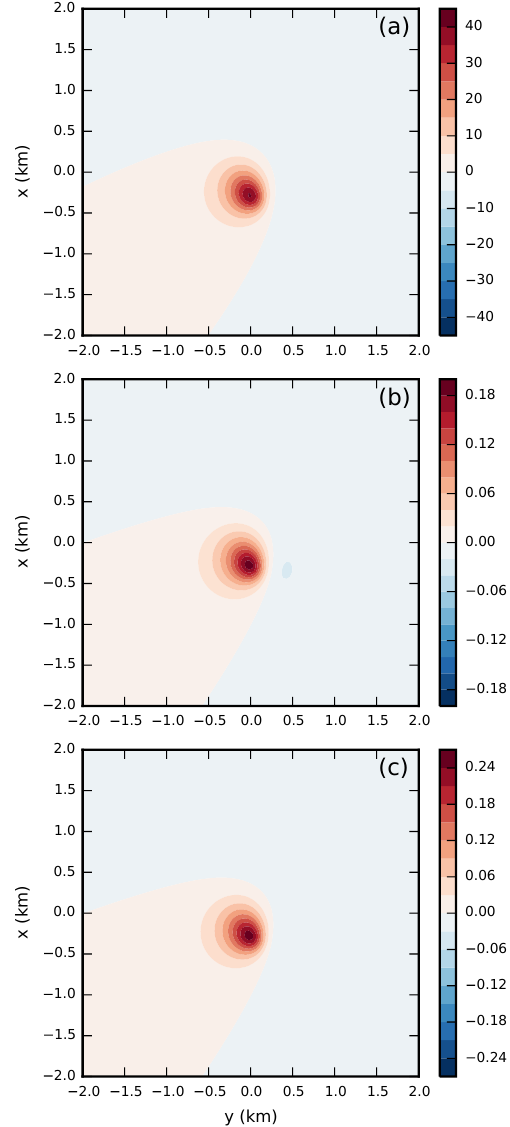
Figure 6. Difference between the total-field anomaly calculated with the approximated magnetization ˘ M (Eq. 51) and with the true magnetization M (Eqs. 49 and 52). The total-field anomalies are in nT and were calculated with Eq. (67), on a regular grid of 100 × 100 points, at the constant vertical coordinate z = 0m. The differences are produced by the synthetic orebody defined in Table 2, but with different isotropic susceptibilities: (a) the isotropic susceptibility defined in Table 2, (b) an isotropic susceptibility χ = 0 . 1SI and (c) an isotropic susceptibility χ = 0 . 116SI. This last value was cal- culated with Eq. (60), by using (cid:15) =